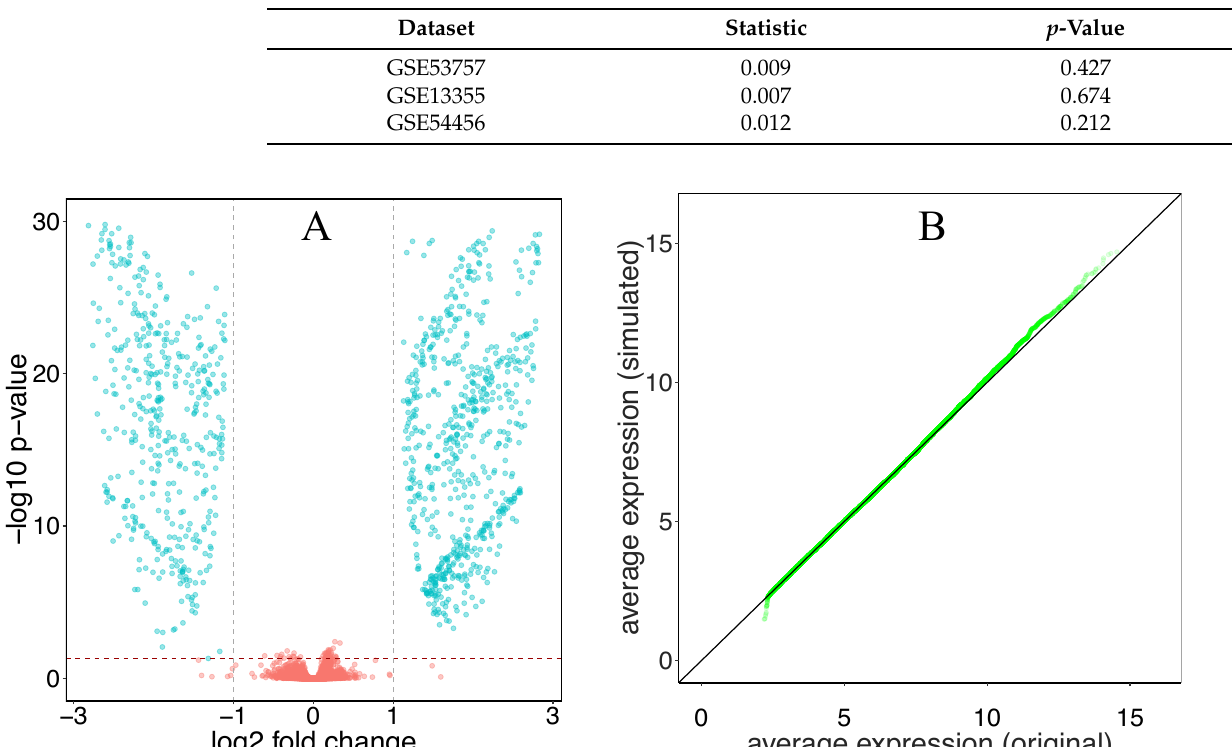
Table 2. The results of Kolmogorov–Smirnov tests comparing each original gene expression dataset to its corresponding dataset synthesized using Silver. The test results suggest that the expression values in each synthesized dataset follow the same distribution as its corresponding real dataset.